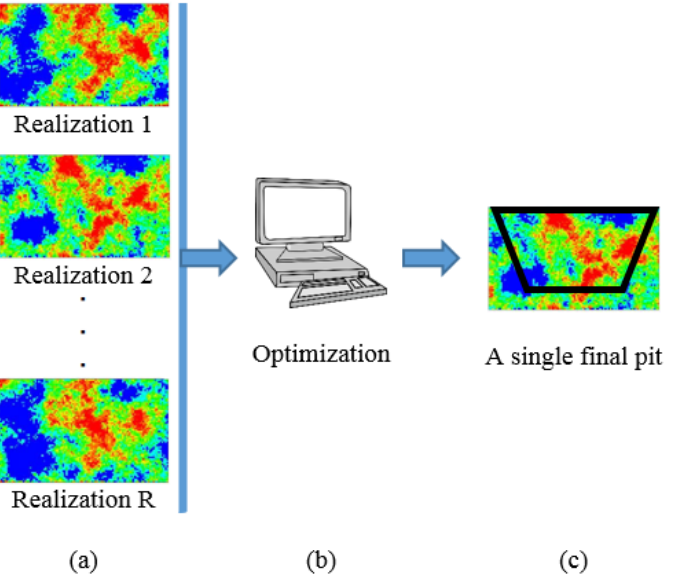
Figure 2. A second approach to compute final pit limit: ( a ) a set of realizations representing the geological uncertainty are used as input simultaneously, ( b ) the optimization computes a single solution for the entire set of realizations, and ( c ) a robust final pit limit is returned. One of the first efforts to include geological uncertainty into the final pit limit is by [26], which presented a hybrid approach within a set-theory framework. This work considered final pits for several simulated realizations of the orebody and then defined the so-called hybrid pit. Later, Refs. [10,27,28] compute pits based on the hybrid approach and propose some reliability indexes for a pit. Ref. [29] proposed to use one of the simulated pits as the best pit design, capturing the upside potential of the orebody and minimizing the potential downside risk. Ref. [30] presented a workflow that includes the computation of a series